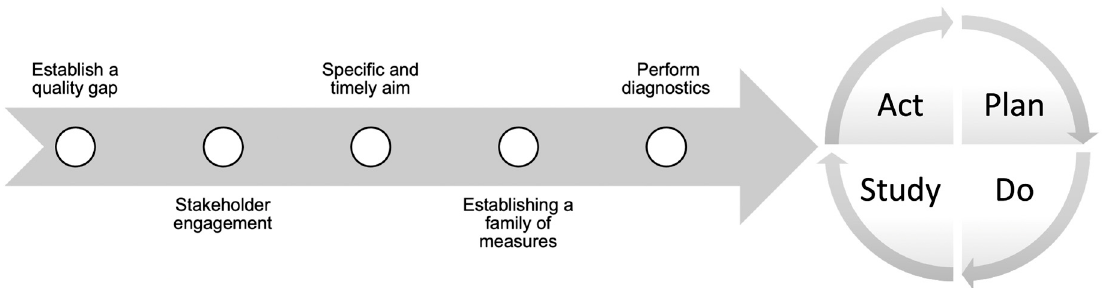
Figure 1. Quality improvement